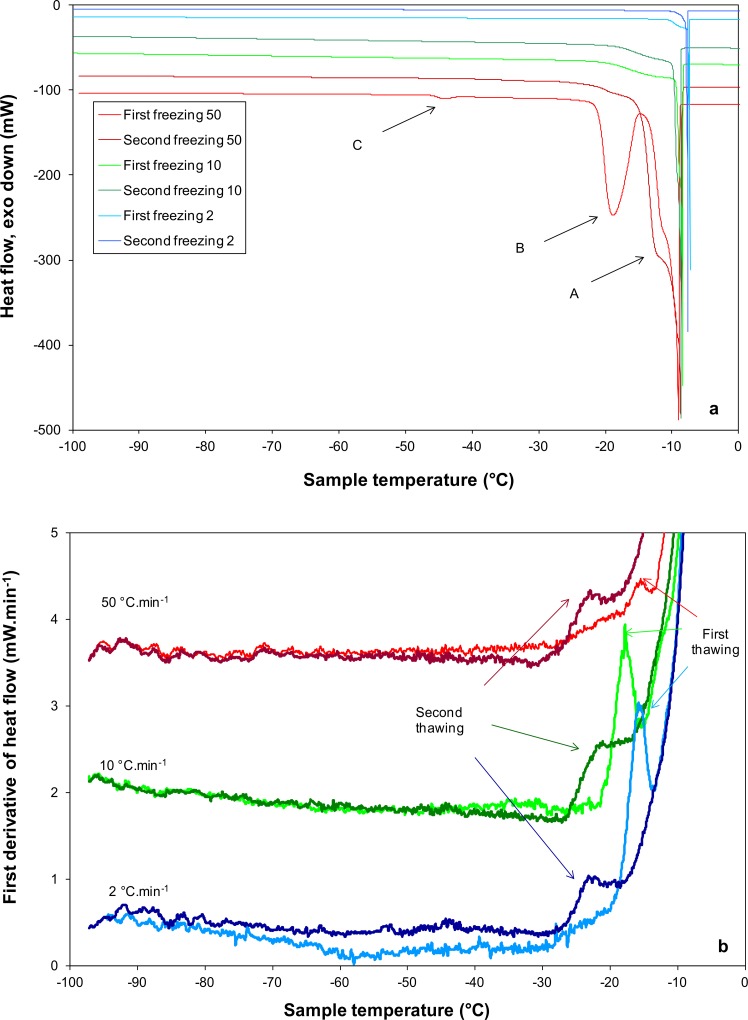
DSC traces of S. cerevisiae 338 cells during cooling.(a) DSC heat flow traces at 50°C.min-1 (red curves), 10°C.min-1 (green curves) and 2°C.min-1 (blue curves) and (b) DSC first derivative of the heat flow during warming at 10°C.min-1. In all figures the effects of a repeat freeze thaw were also determined. Capital letters A, B and C in Fig 2A correspond to exothermic events indicated in Table 1.